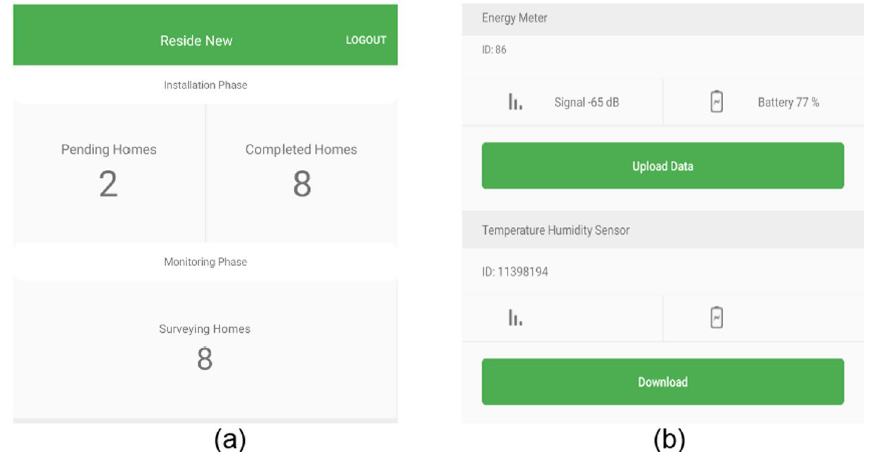
Fig. 5 Screenshots of mobile application used for data